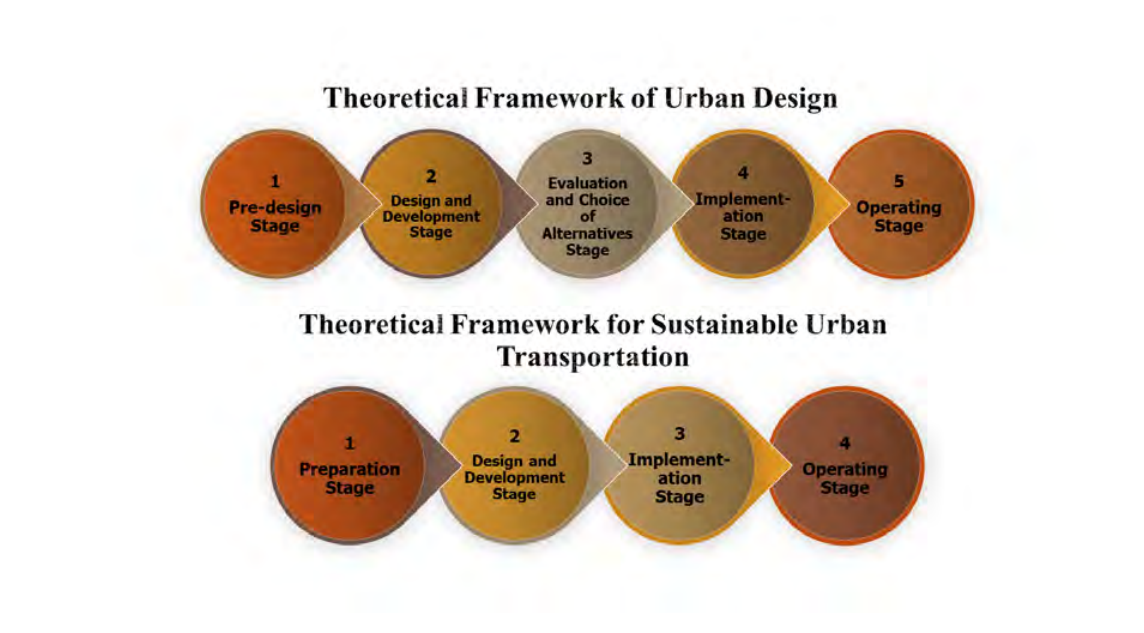
Figure 3. TheoreticalFrameworks for the Urban Design and Urban Transportation